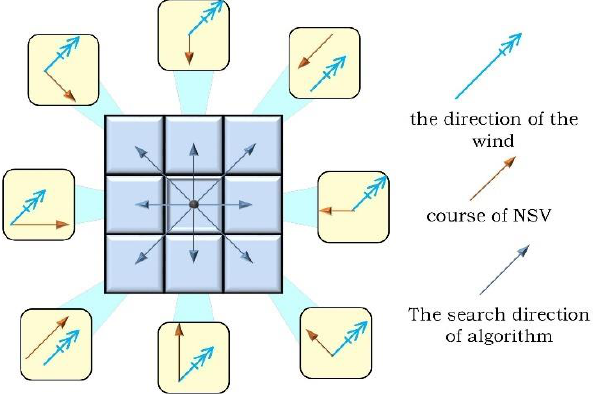
Figure 8. The calculation method of visual wind in reverse